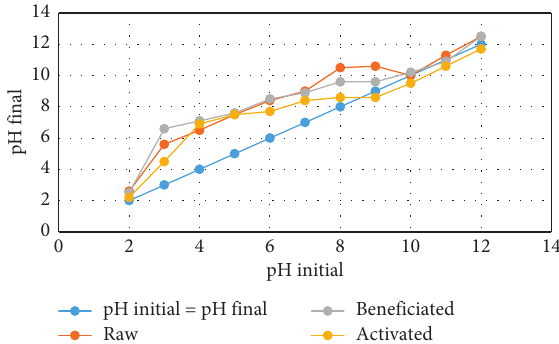
Figure 3: Final pH versus initial pH for PZC determination of waste ash adsorbents.